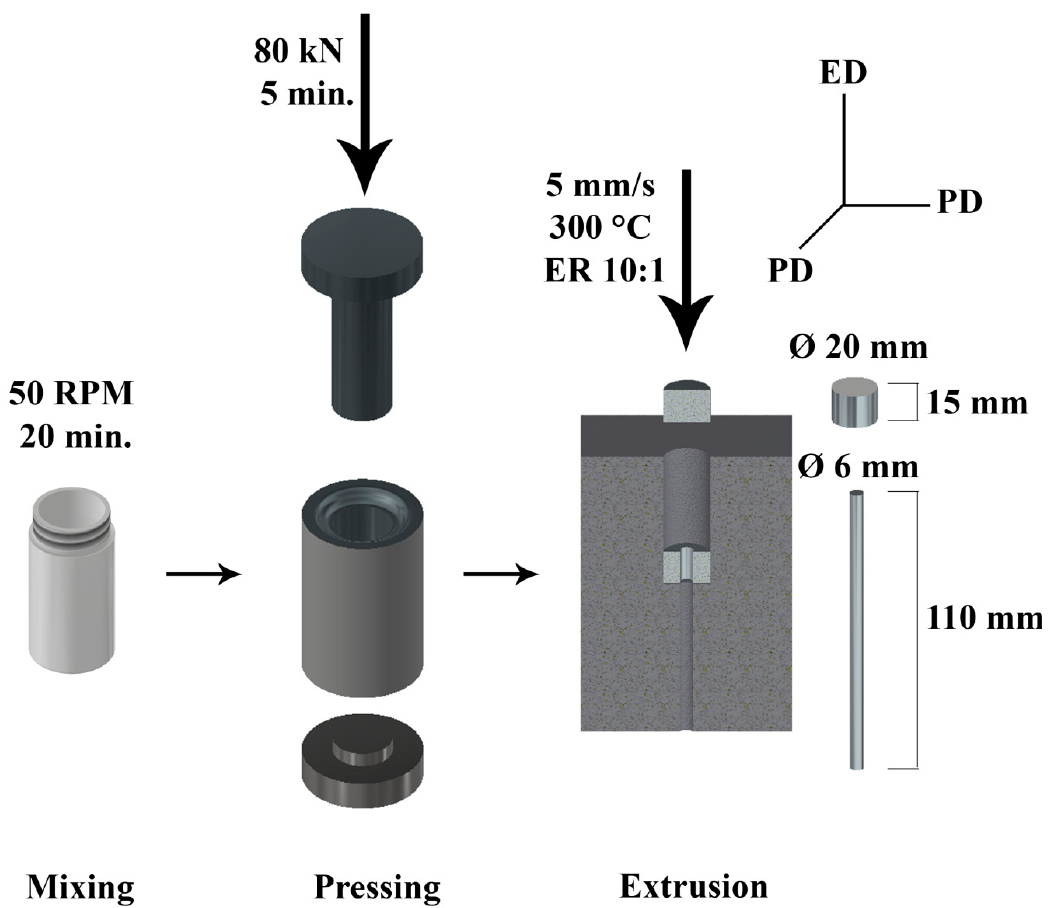
Figure 1. Schema of the Zn / HA8 composite preparation with the processing conditions of individual steps and with the description of the sample directions (ED—extrusion direction, PD—perpendicular direction).